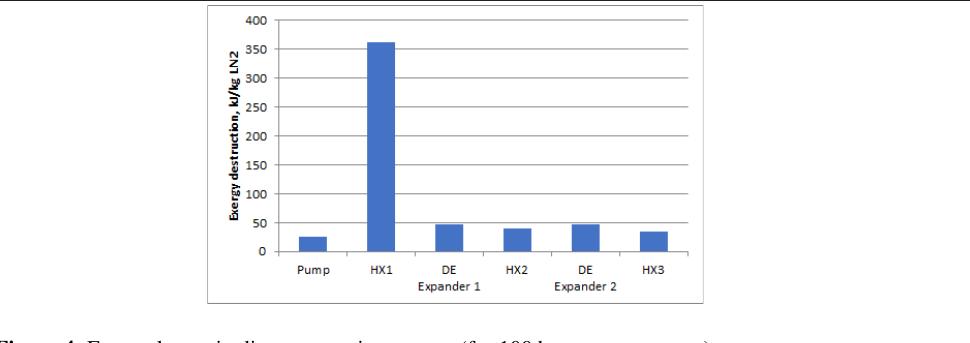
Figure 4. Exergy losses in direct expansion system (for 100 bar pump pressure).